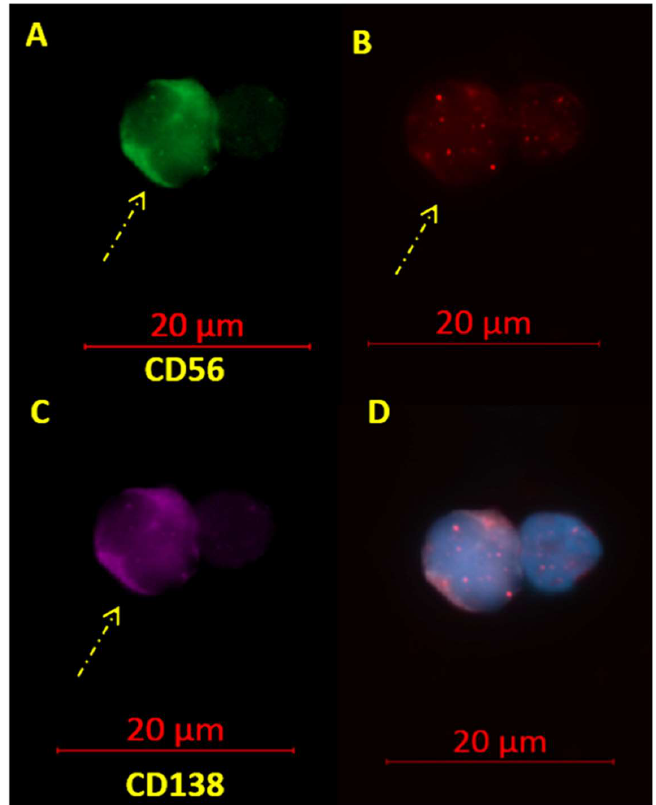
Figure 1. Telomere signals in CD56 + and CD138 + malignant plasma cells ( A – D ). ( A ) CD56 + myeloma cells fluoresce green with Alexa Fluor ® 488 labeled anti-CD56 antibody (see arrows) and normal cells remain unstained. ( B ) The telomeres, hybridized with cyanine 3 (Cy3)-labeled peptide nucleic acid (PNA) probes, appear as red signals. ( C ) CD138 + myeloma cells stain purple with Alexa Fluor ® 594 labeled anti-CD138 antibody (see arrows) while normal cells remained unstained. ( D ) Merged image with the nuclei counterstained with DAPI (blue): Myeloma cells can be di ff erentiated from normal lymphocytes and nonmalignant plasma cells by their doubly positive CD56 and CD138 staining. Table 1. Basic clinical characteristics of the Estonian study population assessed at time of diagnosis. MGUS MM Sample Number ( n )